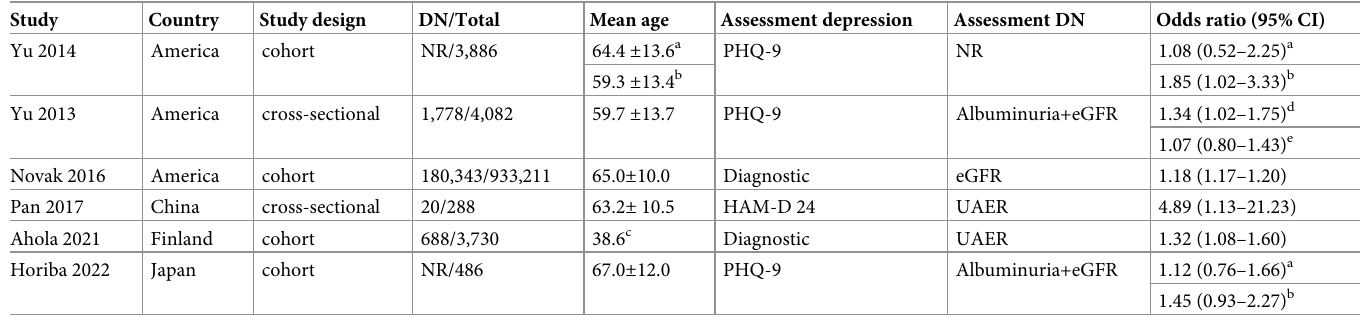
Table 2. Studies of depression and incident diabetic nephropathy